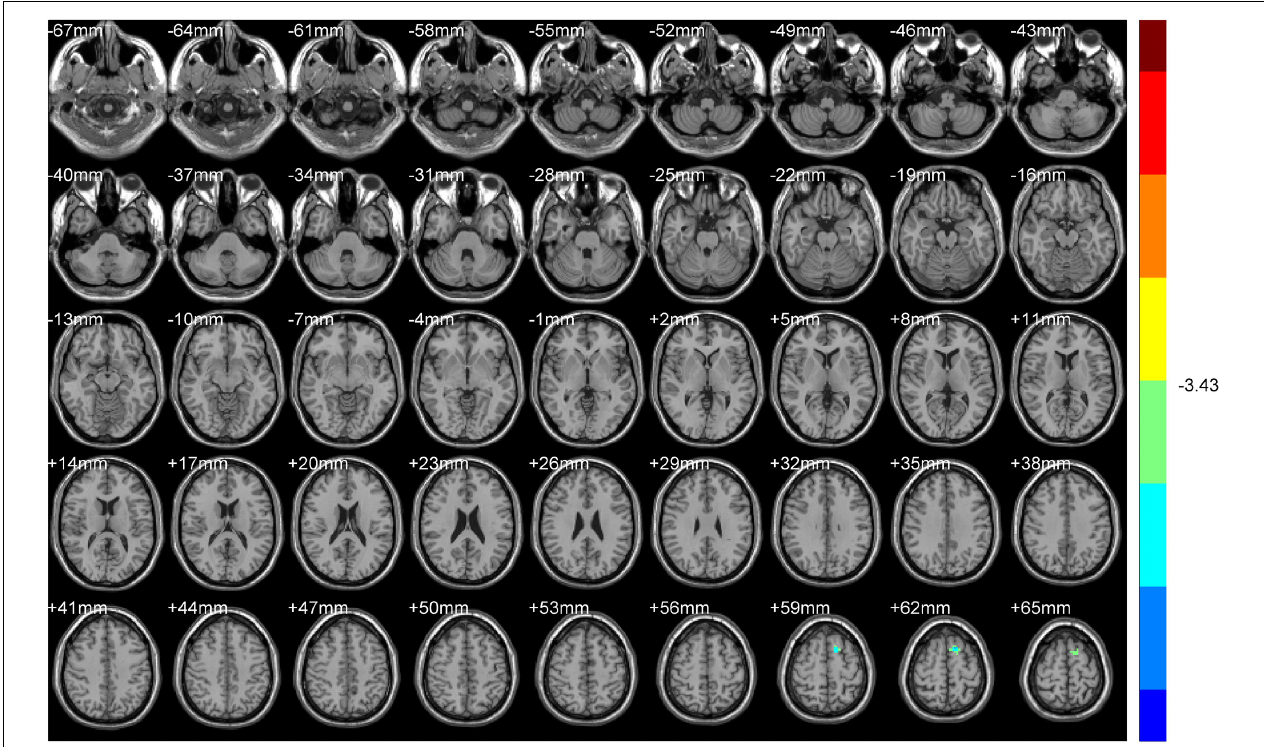
FIGURE 6 | ALFF (Dominant hemisphere vs. Non-dominant hemisphere).